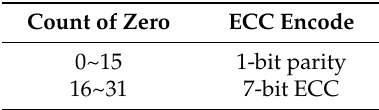
Table 2. Filter rule of the proposed